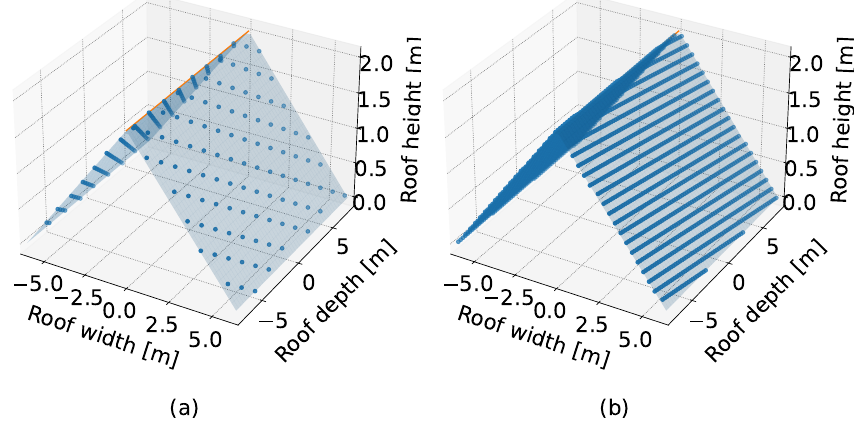
Figure 2. A render of the roof model we used for our Monte Carlo simulation, with a rendered mea- surement grid overlaid on top and roof ridge marked in orange. Subplot ( a ) corresponds to LoD1 measurement grid, with a grid spacing of 1 × 1m. Subplot ( b ) corresponds to LoD2 measurement grid, × 1 with a grid spacing of 1 m. The dimensions we used here are width = 12.44m, depth = 15.65m, 3 4 height =